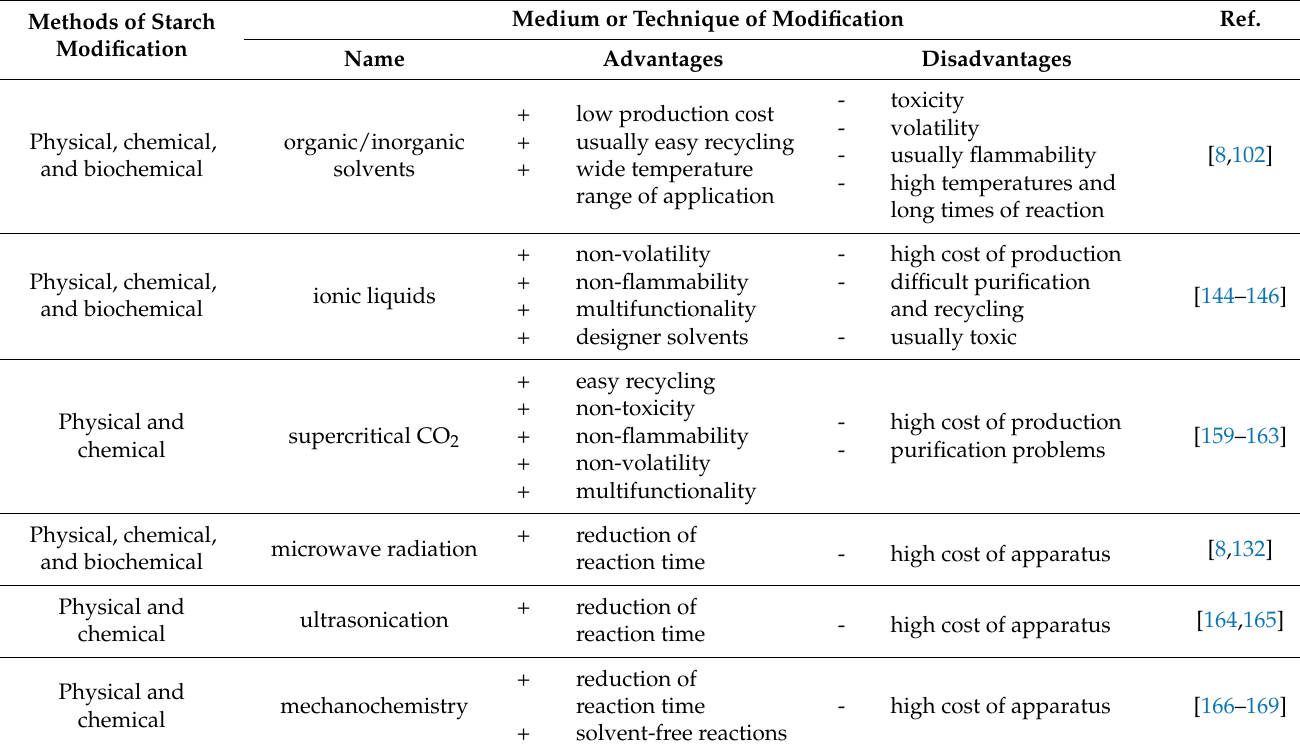
Table 6. Advantages and disadvantages of the most commonly used media and techniques in starch modification. Methods of